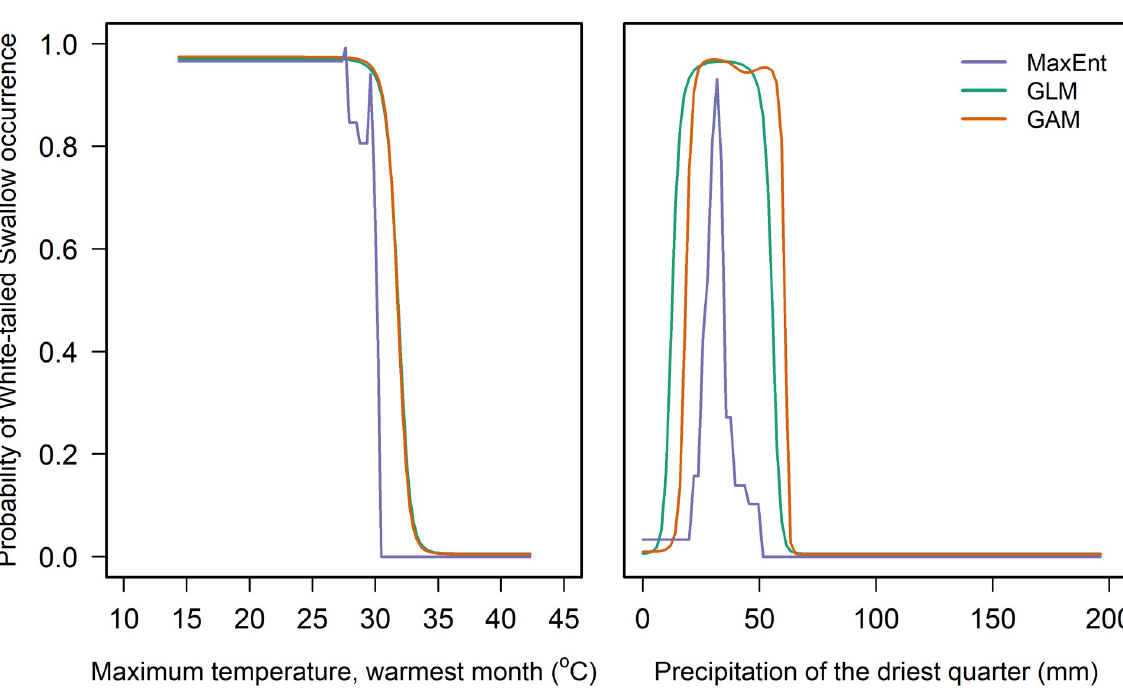
Fig 3. The relationship of modelled partial probability of occurrence of White-tailed Swallow to (left) maximum temperature of the warmest month and (right) precipitation of the driest quarter. All other bioclimate variables are held constant. Curves show the predicted responses determined using the three model algorithms (Maximum Entropy, Generalised Linear Model, Generalised Additive Model) that gave the highest AUC values in a k -fold leave-one-out cross-validation test. Equivalent plots for all five bioclimate variables and all model algorithms are presented in S1 Fig in S1